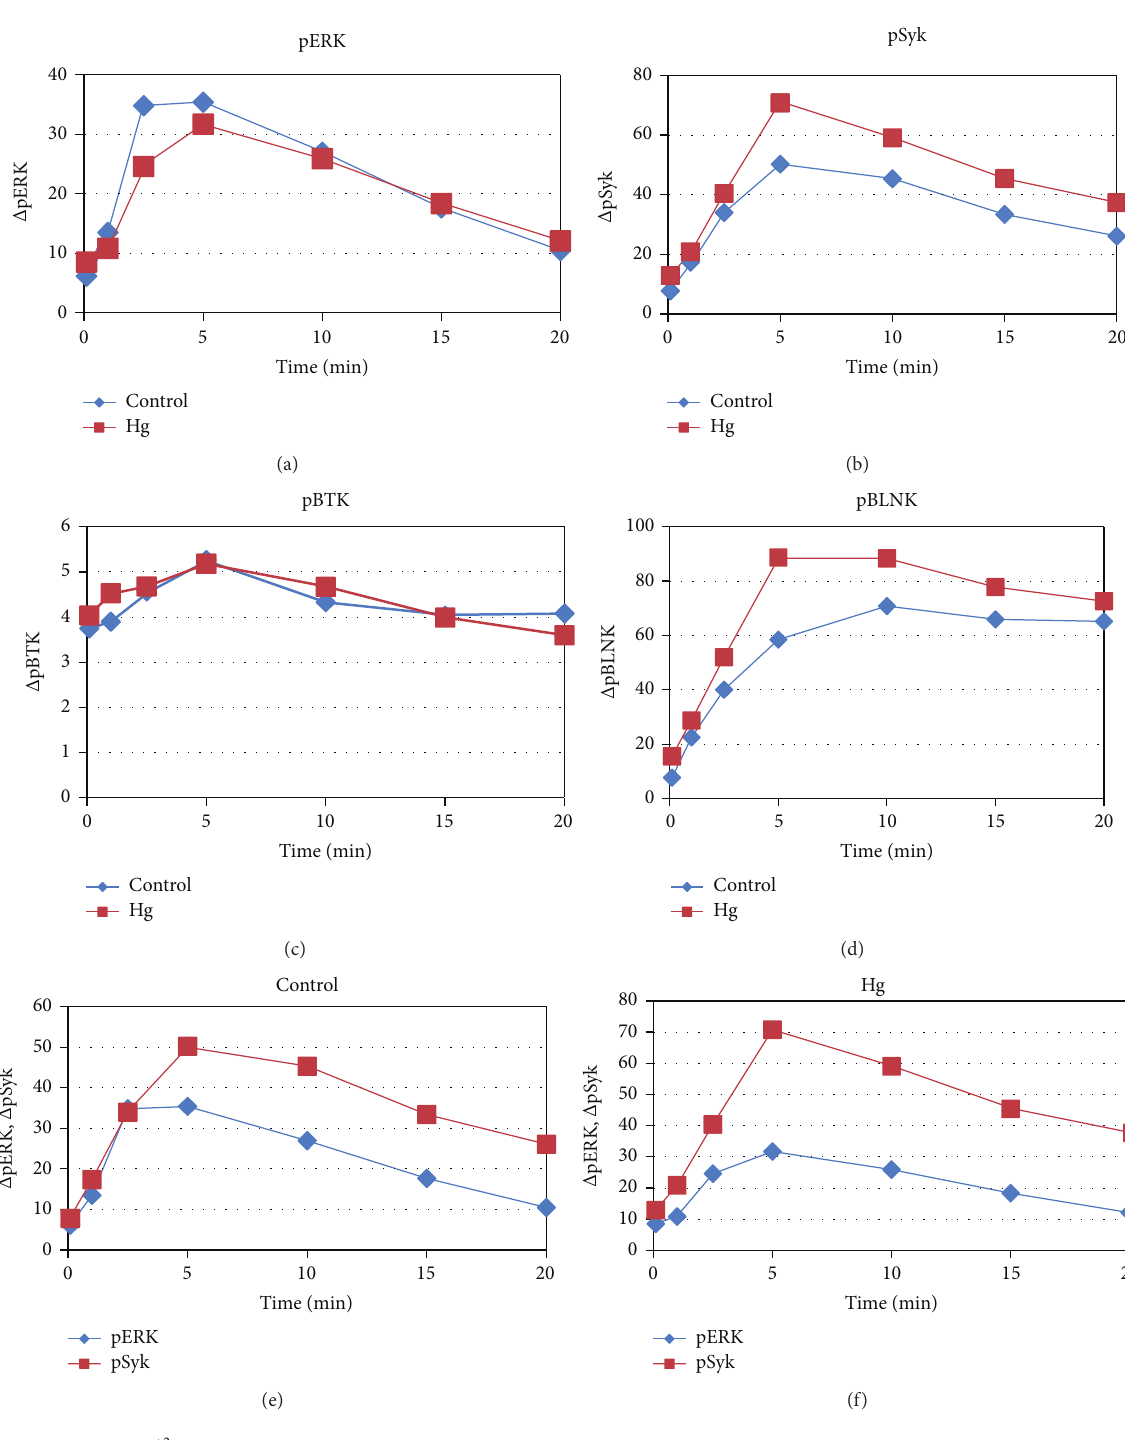
Figure 4: Effect of Hg +2 on stimulation of elements of the BCR signal transduction pathway after stimulation of the BCR with anti-mu (12.5 𝜇 g/mL). In Figure 4 the y -axis represents differences in MFI between (BCR stimulated cells treated or not with Hg 2+ ) and control cells which have neither been treated with Hg nor stimulated via the BCR. The x -axis represents time after stimulation of the BCR. (a) pERK versus time, (b) pSyk versus time, (c) pBtk versus time, (d) pBLNK versus time, (e) pERK versus pSyk versus time in the absence of Hg +2 , and (f) pERK versus pSyk in the presence of Hg +2